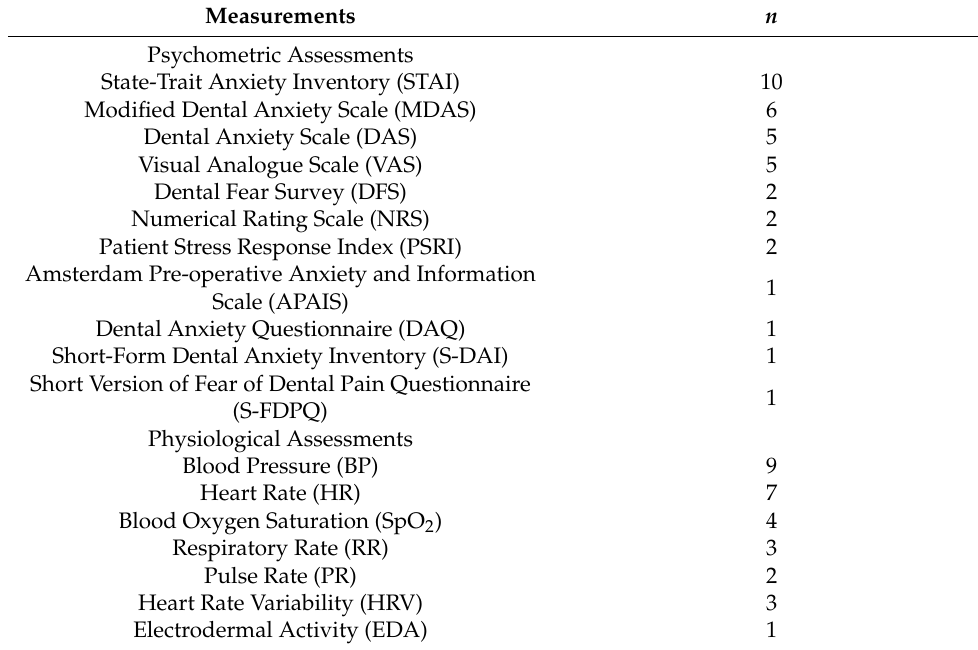
Table 2. The use of measurement tools of included studies in systematic review. Measurements n Psychometric